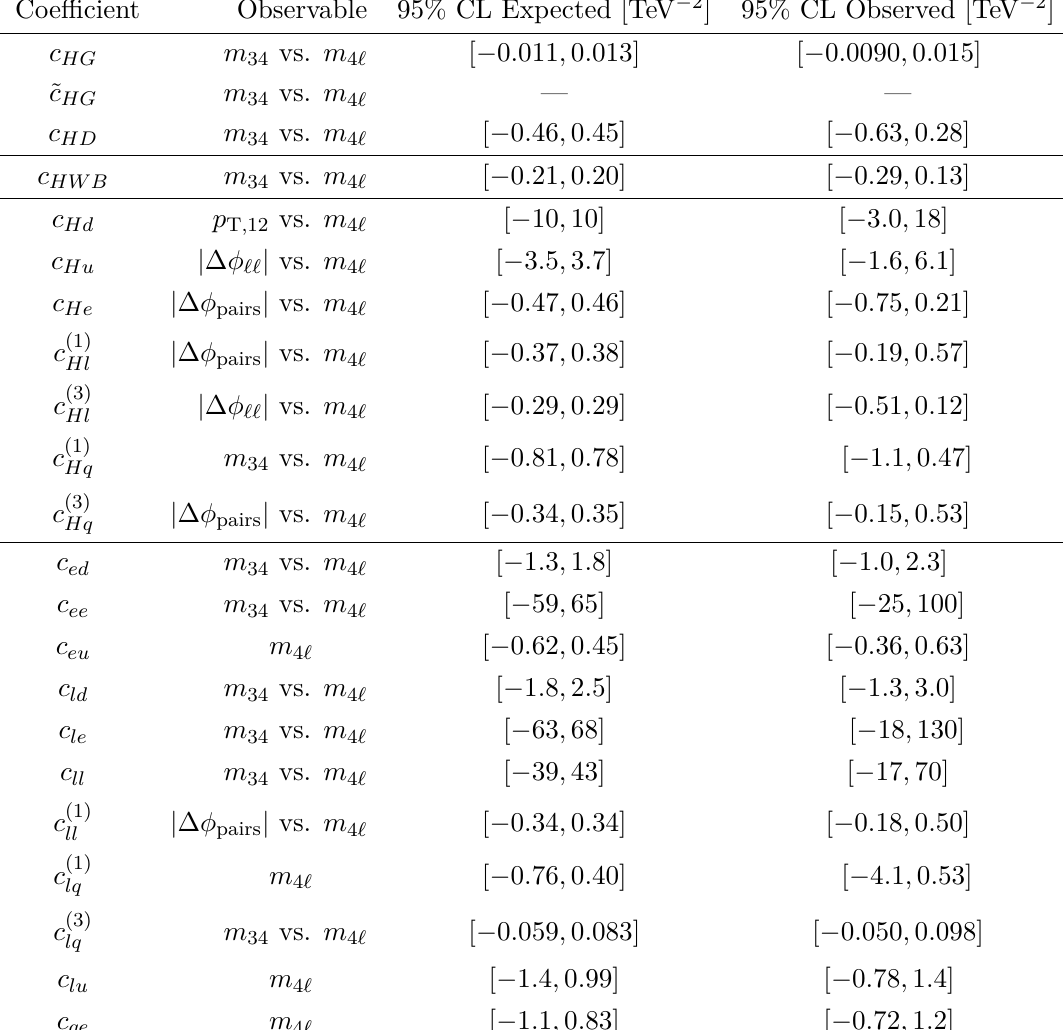
Table 4 . The expected and observed confidence intervals at 95% CL for the SMEFT Wilson coefficients, including only linear terms. The most sensitive observable indicated for each coefficient is used for the constraints. Only one coefficient is fitted at a time, with all others set to